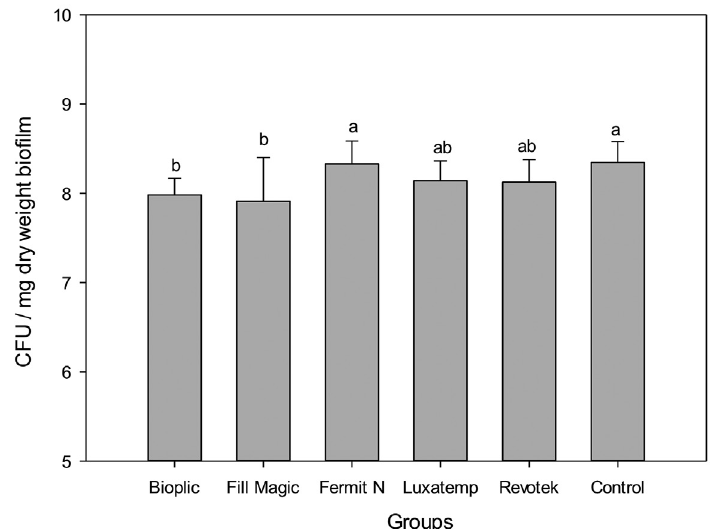
Figure 3- S. mutans (UA159) accumulation test after 3 days of biofilm formation under continuous exposure to 1% sucrose. Different letters represent statistically significant differences between groups